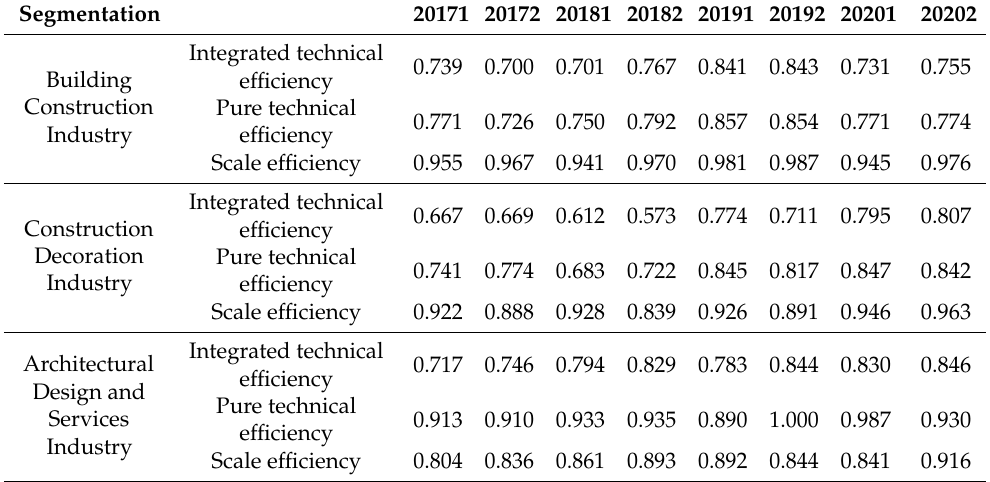
Table 9. Average of green financing efficiency in the third stage by subsector.